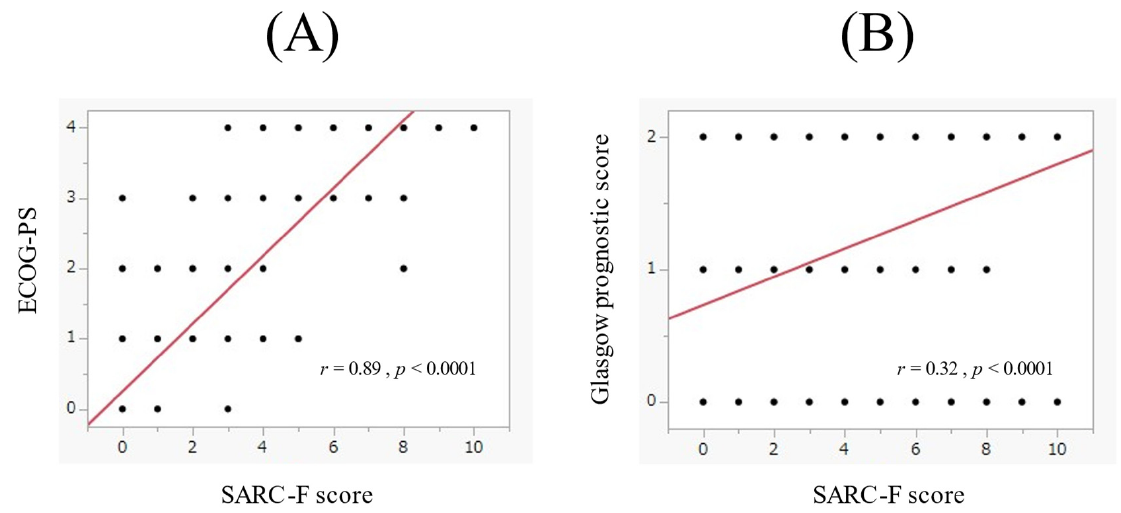
Figure 2. ( A ) The relevance between the SARC-F score and the ECOG-PS. ( B ) The relevance between the SARC-F score and the Glasgow prognostic score.